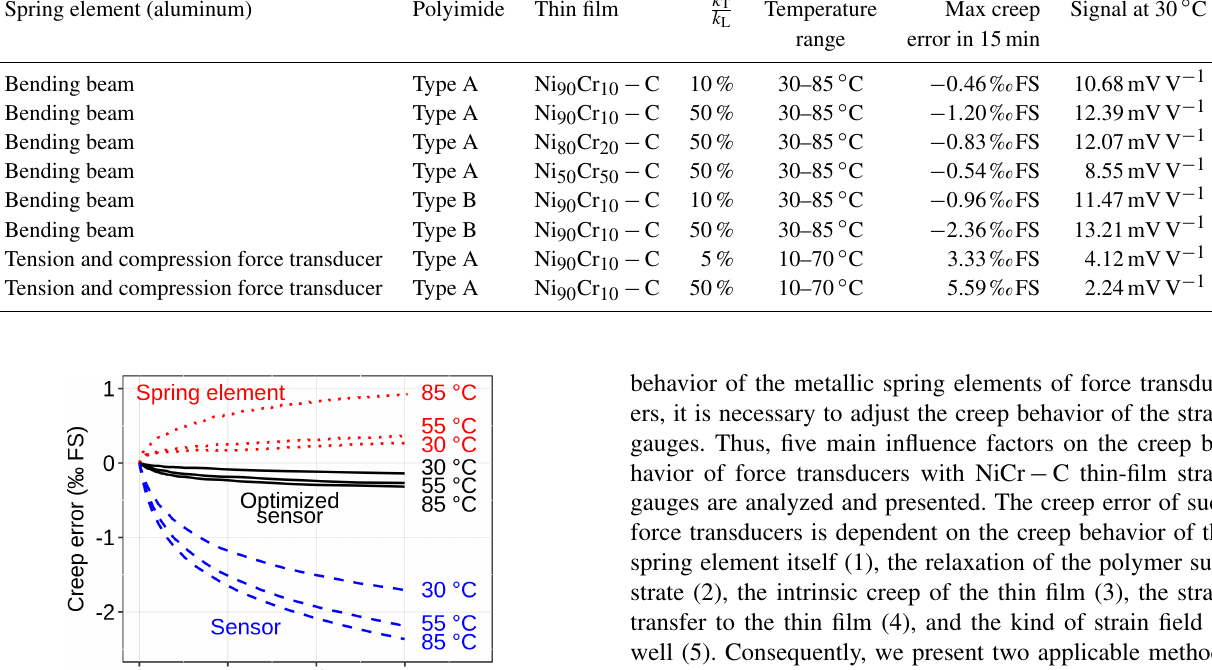
Table 2. Overview of examined force transducers, their maximum measured creep errors in the temperature range and the corresponding sensor signals at 30 ◦ C. The force transducers consist of a spring element and a Wheatstone bridge of four strain gauges. The strain gauges are categorized with respect to the used polyimide (polymer substrate), thin film, and ratio of transverse and longitudinal gauge factor k T /k L . Spring element (aluminum)